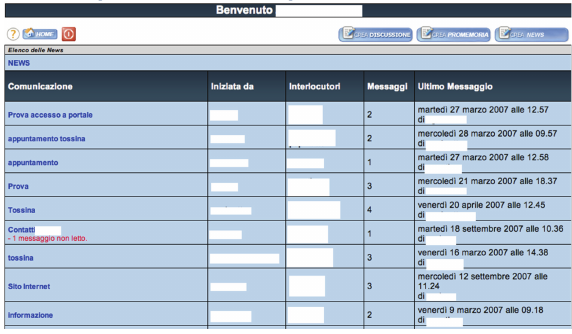
Figure 1: The web portal main communication